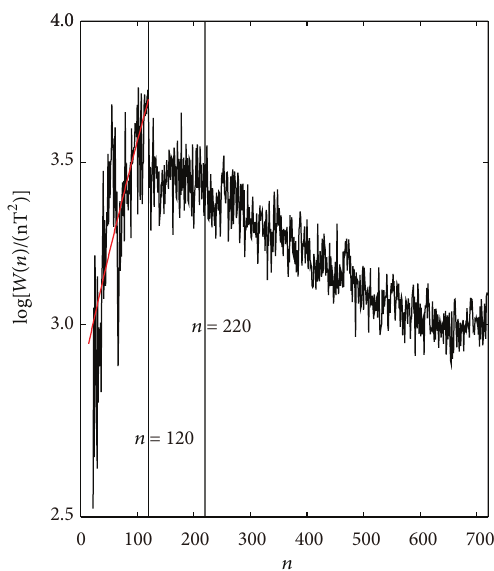
Figure 4: Spherical geomagnetic energy spectra of the NGDC-720- V3 model with the harmonic order 𝑛